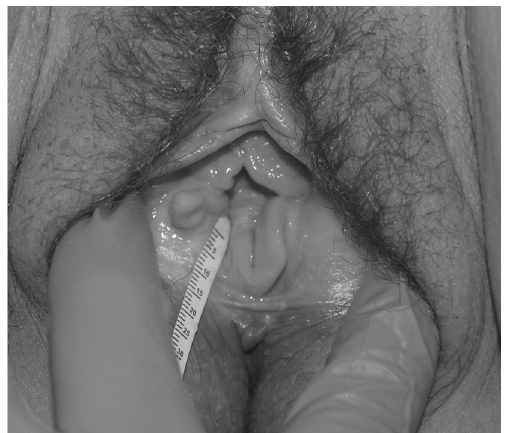
Figure 1. Modified Schirmer test—paper strip location. Measurement of vaginal moisture is performed by placing the tip of a calibrated filter paper test strip adjacent to the remnants of the hymenal tissue on the right side of the vaginal opening, at the “7 o’clock” location.